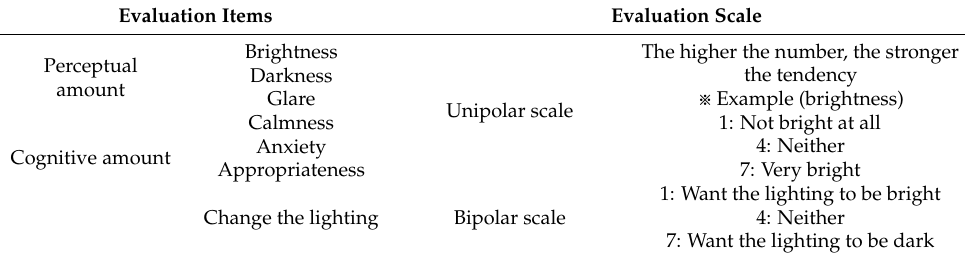
Table 4. Impression evaluation